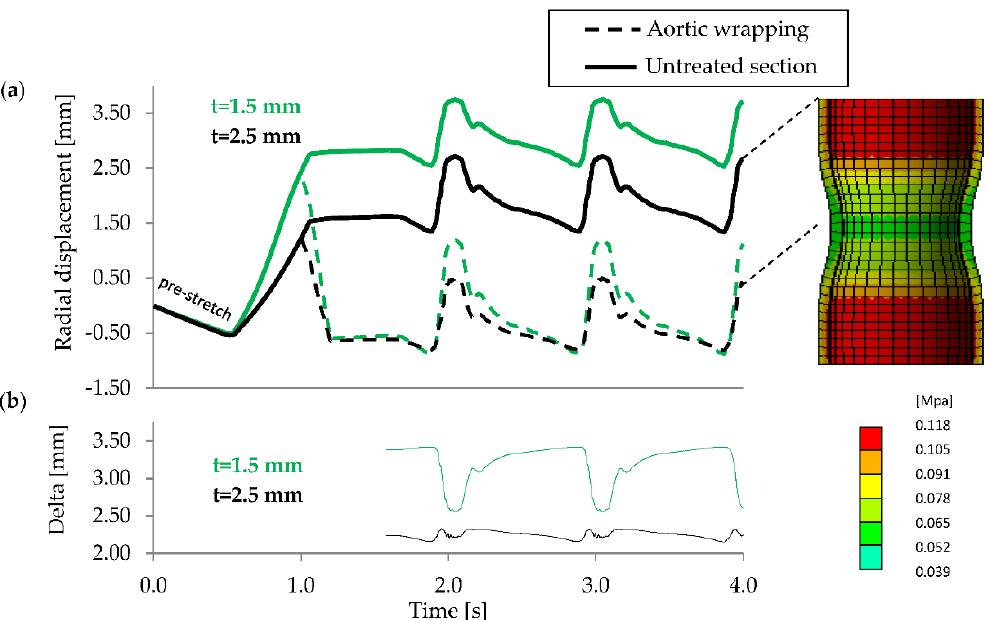
Figure 4. Radial displacement over time of two deformation probes along aortic model, comparing wall thicknesses of 1.5 mm and 2.5 mm ( a ); and the difference between untreated and compressed section for model thickness of 1.5 mm and 2.5 mm ( b ).